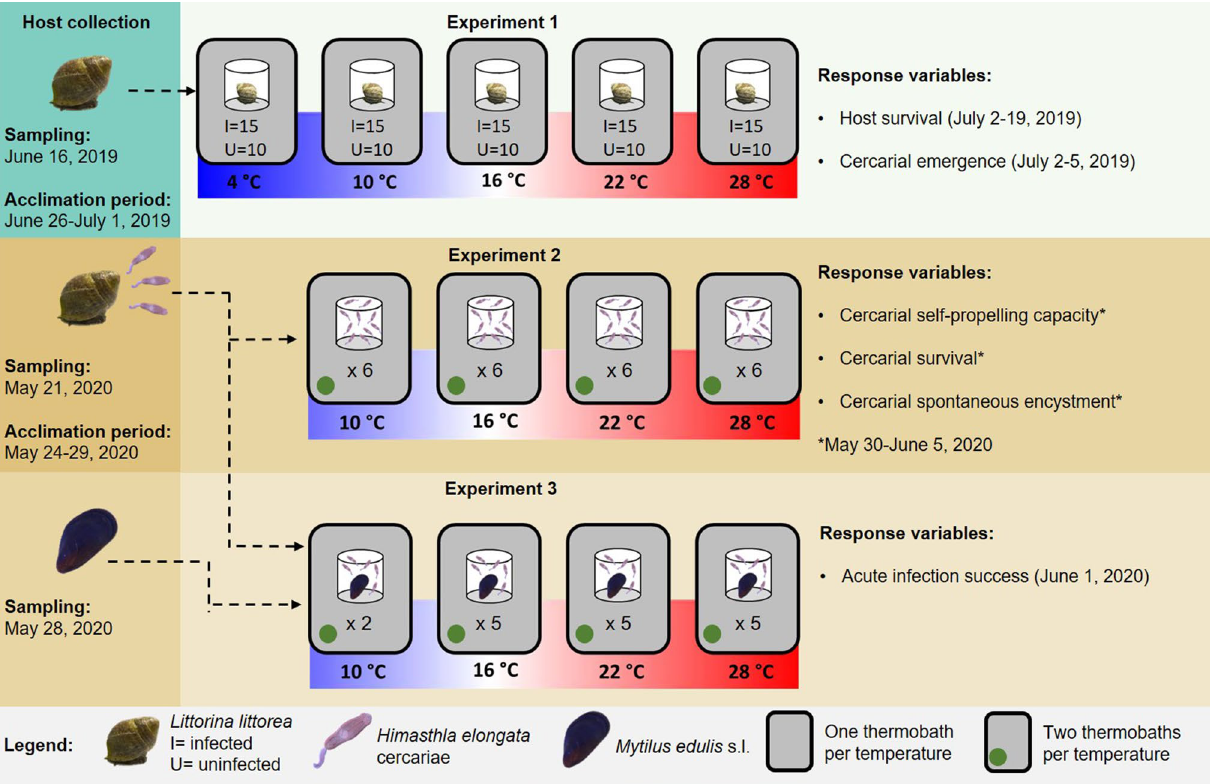
Figure 1. Schematic representation of the experimental design. In Experiment 1, the survival of infected and uninfected Littorina littorea was evaluated along with cercarial emergence at 4, 10, 16, 22, and 28 °C. In Experiment 2, the performance of cercariae at 10, 16, 22, and 28 °C was assessed by evaluating their self-propelling capacity and survival and encystment rates. In Experiment 3, acute infection success of Himasthla elongata to Mytilus edulis s.l. was evaluated at 10, 16, 22, and 28